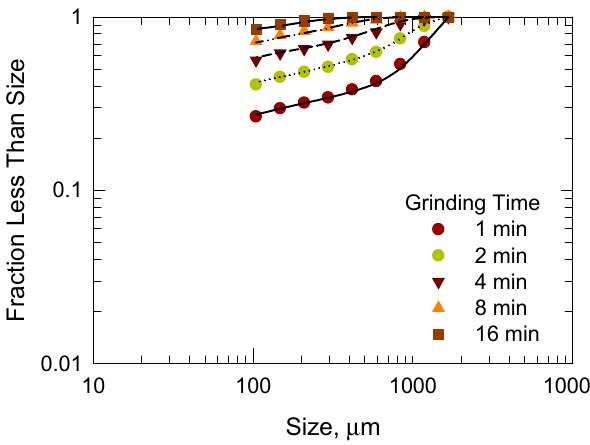
Figure 8. Experimental and simulation product size distributions for various batch grinding times (solid lines indicate the simulation results) for ( W ) .